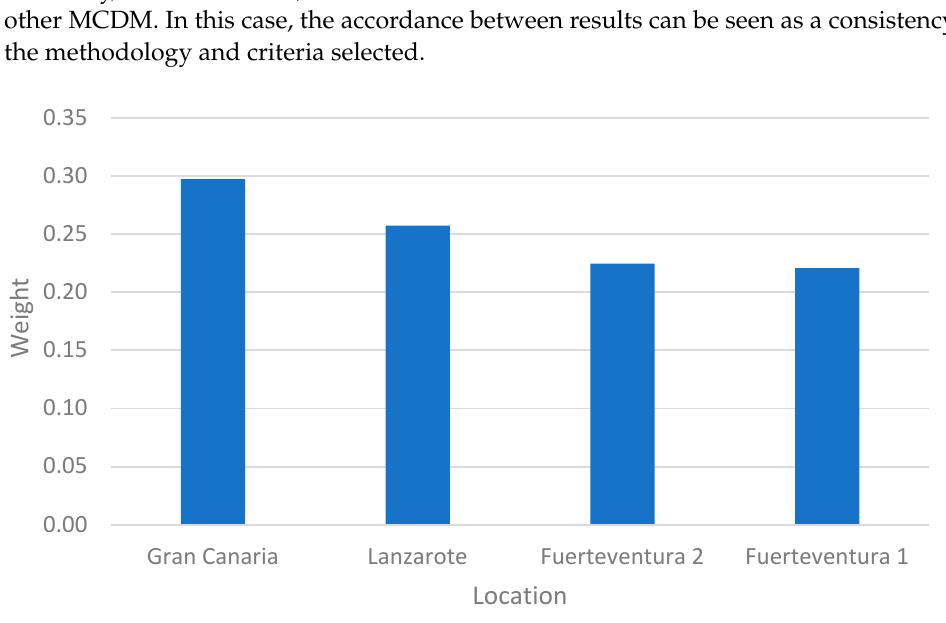
Figure 4. Locations weight using the analytic hierarchy process (AHP). The locations are weight- ranked in the following order, Gran Canaria (0.297), Lanzarote (0.257), Fuerteventura 2 (0.224) and Fuerteventura 1 (0.220).